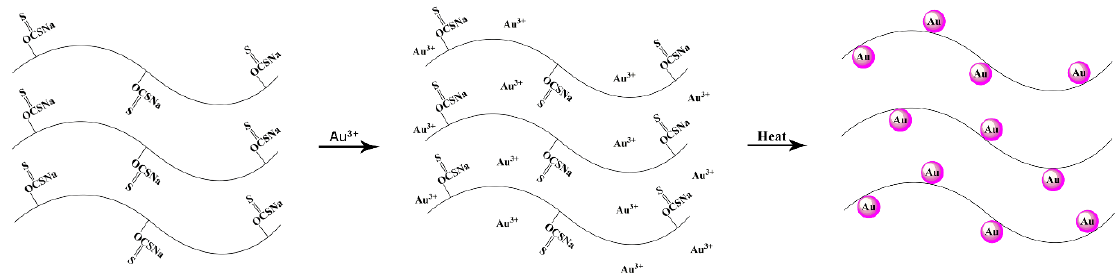
Figure 1. Schematic architecture of Au nanoparticles (AuNPs)@viscose cellulose sponge (VCS).